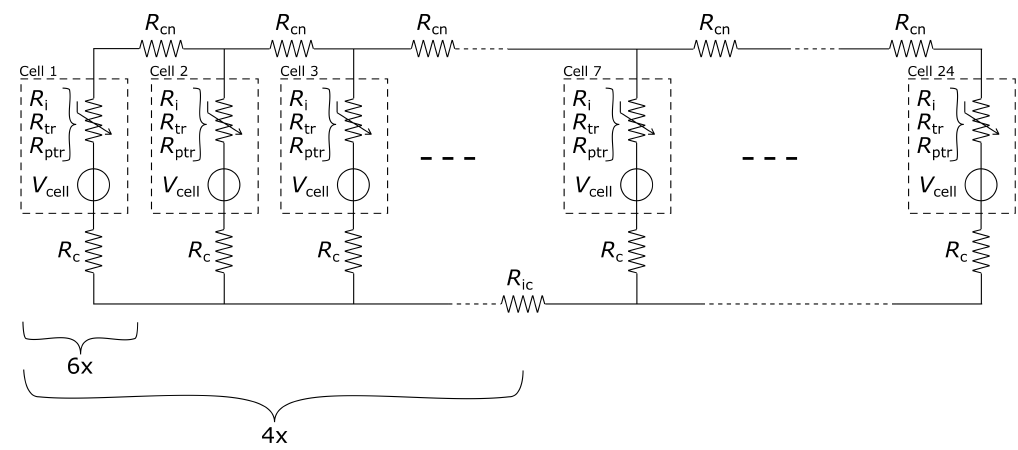
Figure 5. Equivalent circuit model of the experimental set-up. A cell comprises a variable resistor ( R i , R tr or R ptr ) and a voltage source V cell . The cell to cell connection resistance is represented by R cn and the wiring for current measurements by R c . For more flexibility of the set-up a clamp bridge was used if needed to connect the blocks of six parallel-connected cells to 12p or 24p, represented by R ic .